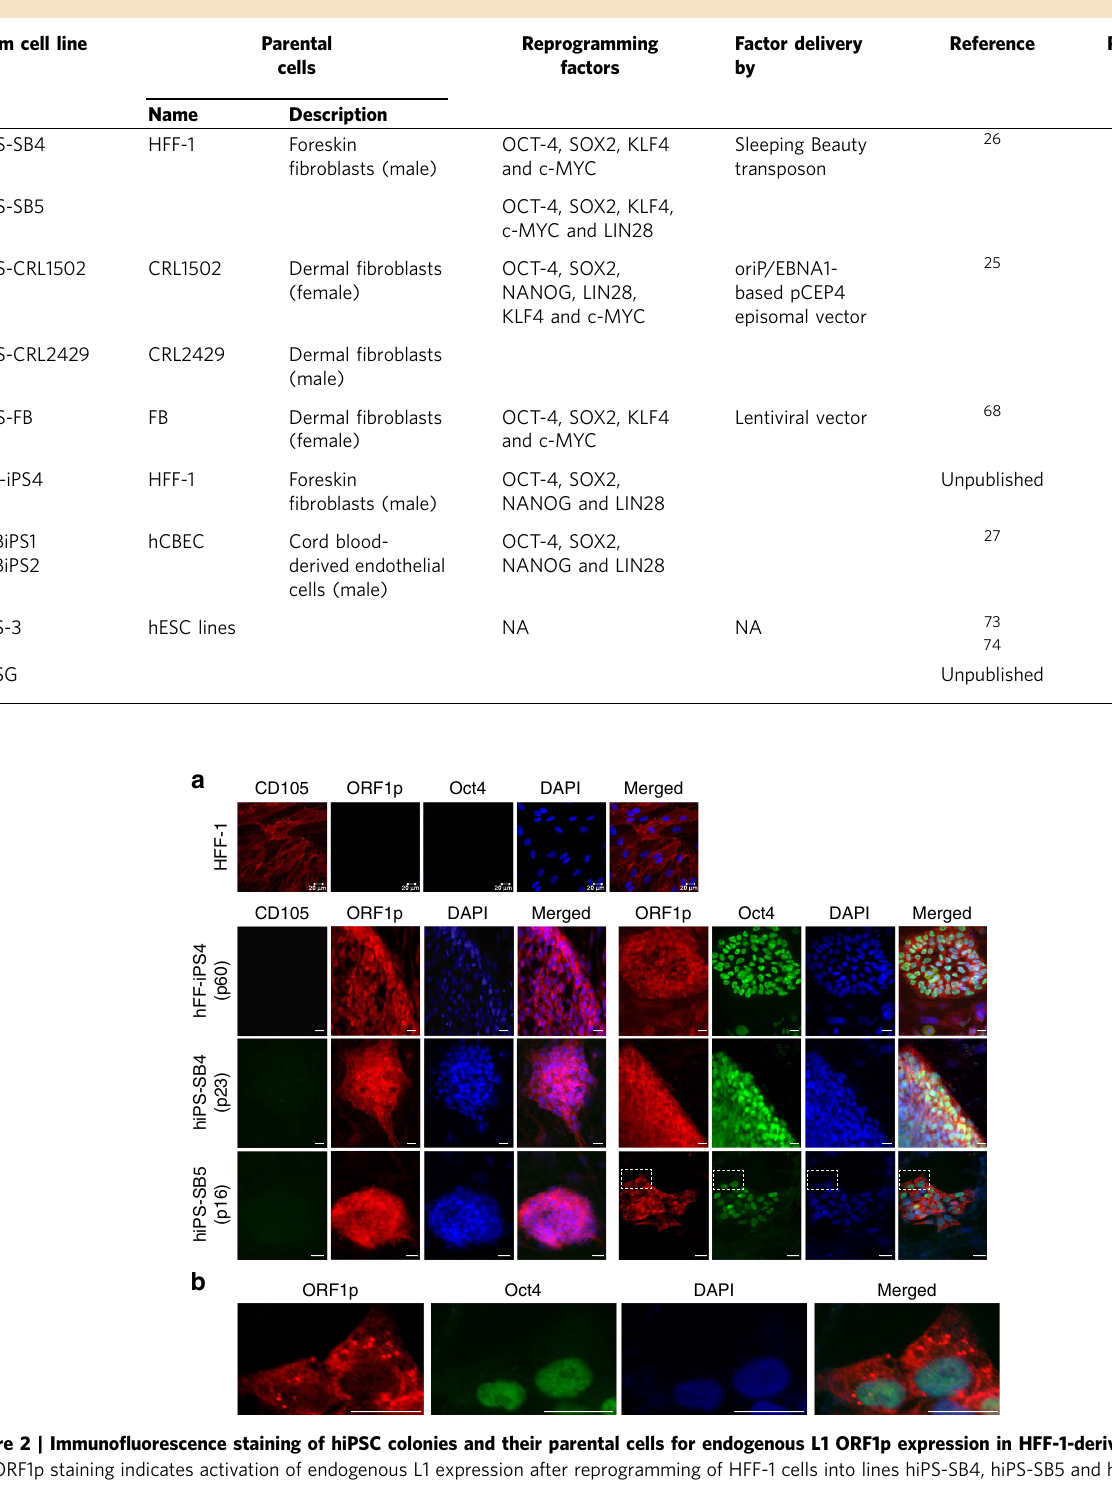
Table 1 | Analysed pluripotent stem cell lines and their characteristics.